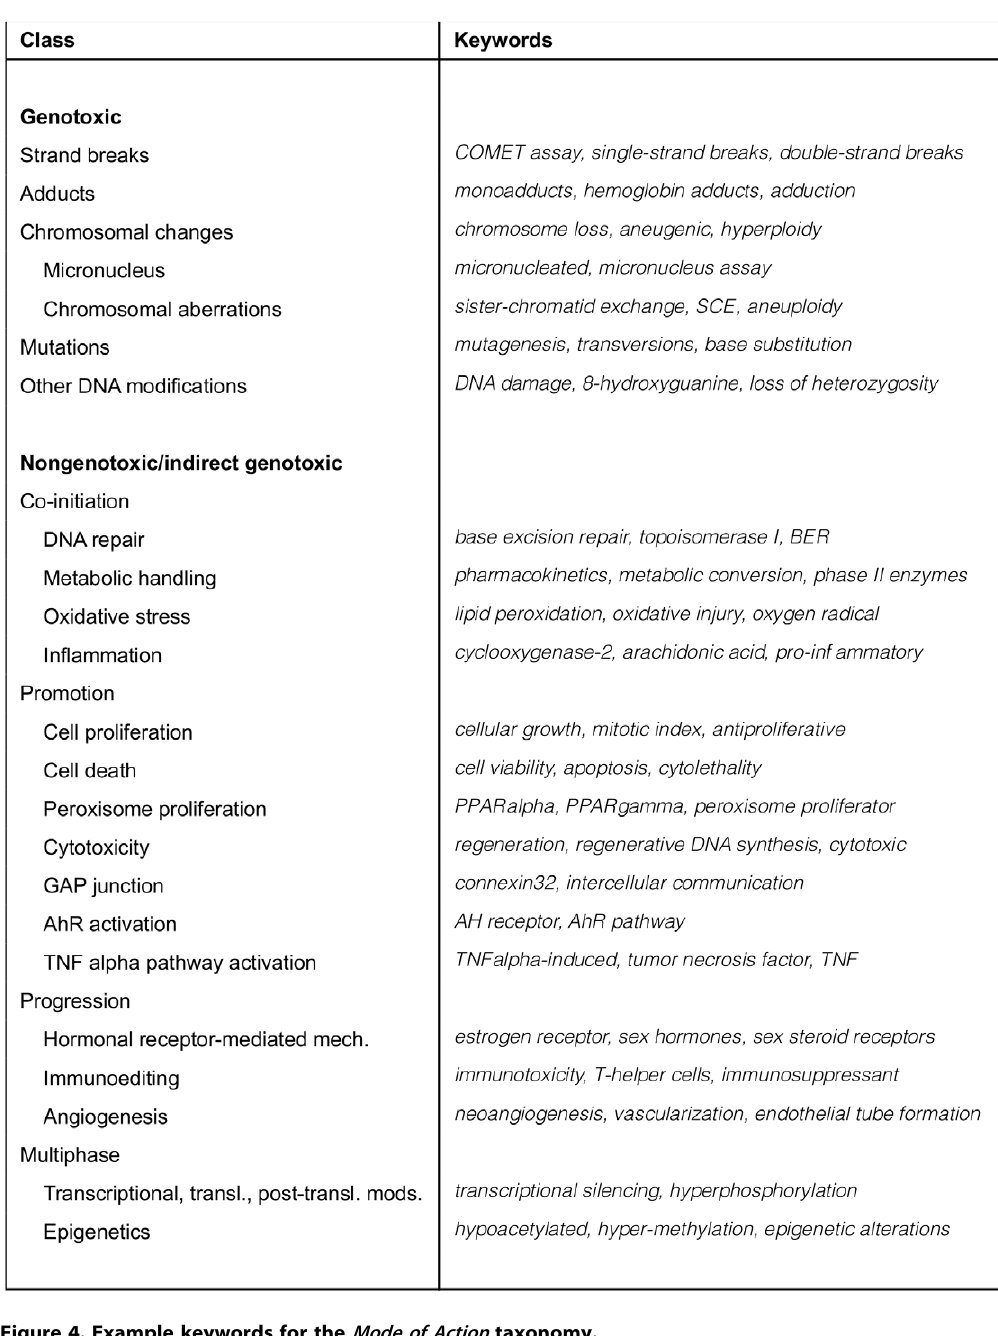
keywords for the MOA taxonomy branch. The keywords shown were selected from the annotated corpus described below.